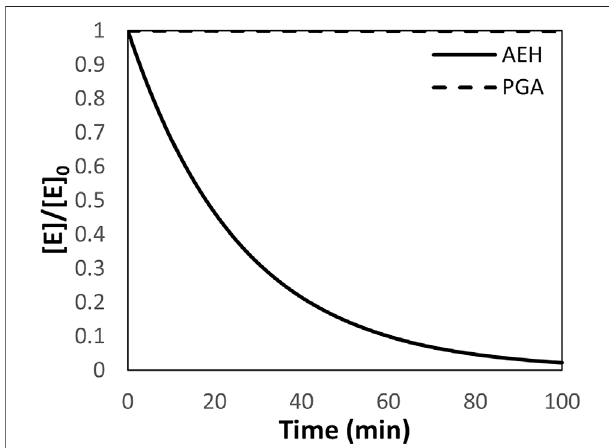
FIGURE 2 | The deactivation of AEH and PGA depicted as the ratio of enzyme at time, t, relative to the initial concentration of enzyme assuming fi rst orderdeactivationkinetics.Thedeactivation constantforAEHis0.0386min − 1 while the deactivation constant for PGA is 7E-8 min − 1 (McDonald et al., 2018). PGA is shown for comparison.